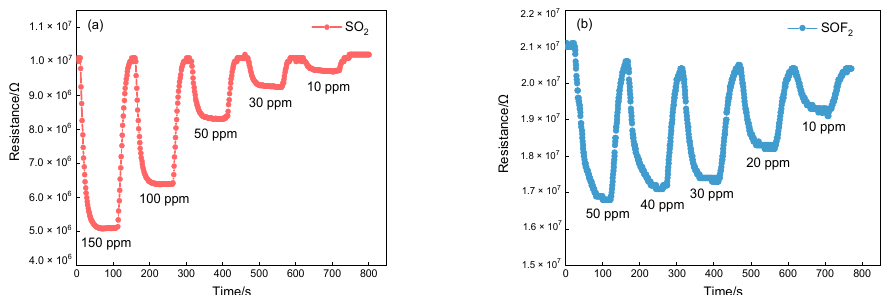
Figure 6. Concentration–response characteristics of the sensor to SF 6 decomposition components. ( a ) SO 2; ( b ) SOF 2 .